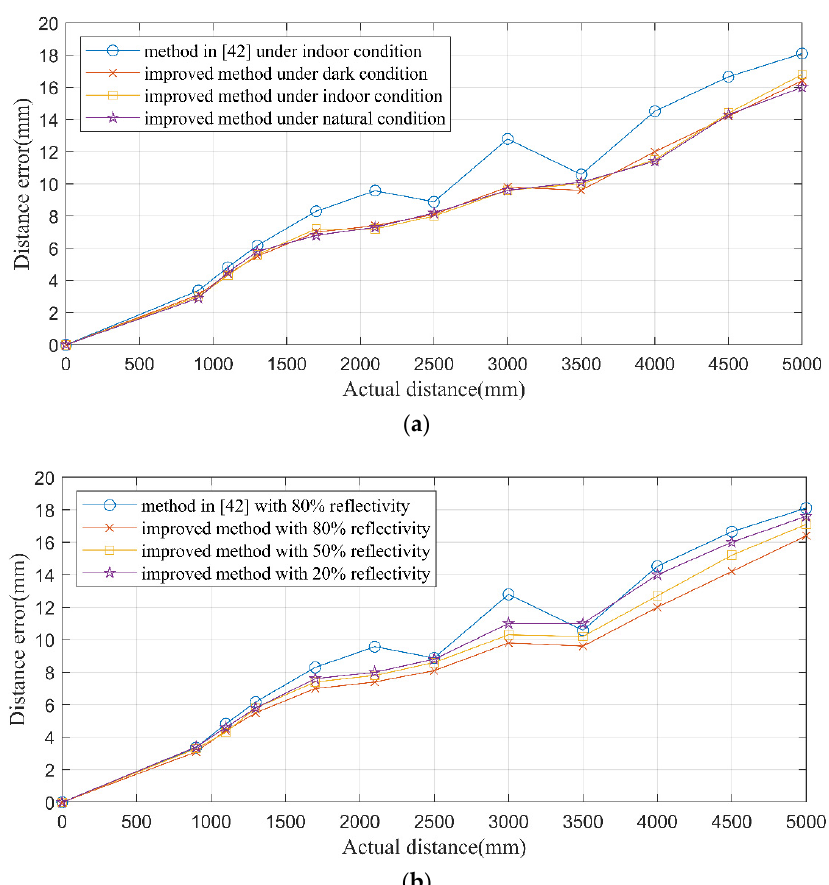
Figure 14. The test results. ( a ) Under different ambient conditions and ( b ) with targets of different reflectivities.